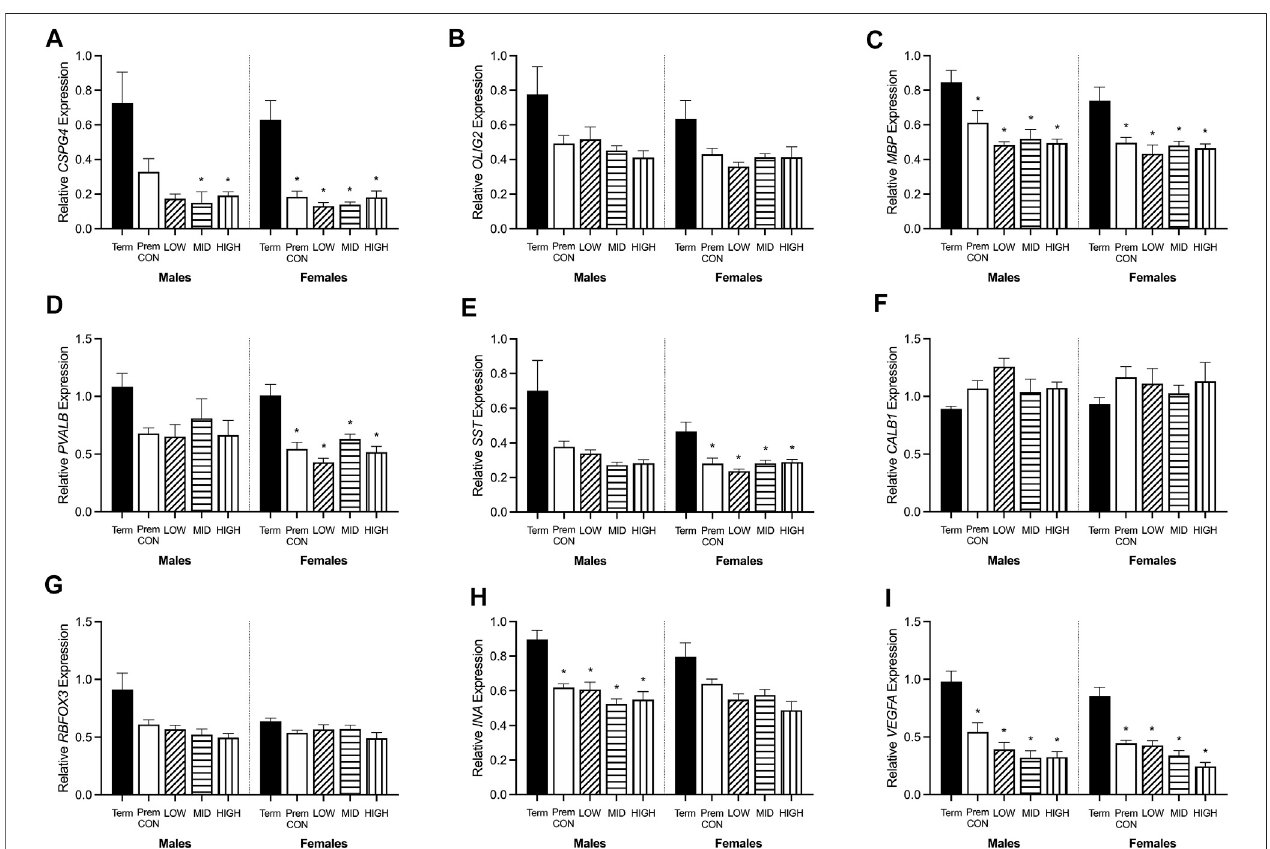
FIGURE 4 | Relative mRNA expression for oligodendrocyte and neuronal markers in the hippocampus of term control (black; males n = 8, females n = 7), preterm control(white;males n =7,females n =6),low-GNX(diagonalstripes;males n =5,females n =6),mid-GNX(horizontalstripes;males n =6,females n =6),andhigh-GNX (vertical stripes; males n = 6, females n = 6). (A) CSPG4 , (B) OLIG2 , (C) MBP , (D) PVALB , (E) SST , (F) CALB1 , (G) RBFOX3 , (H) INA , and (I) VEGFA . Datapresented as means ± SEM with * indicating signi fi cance at p < 0.05.